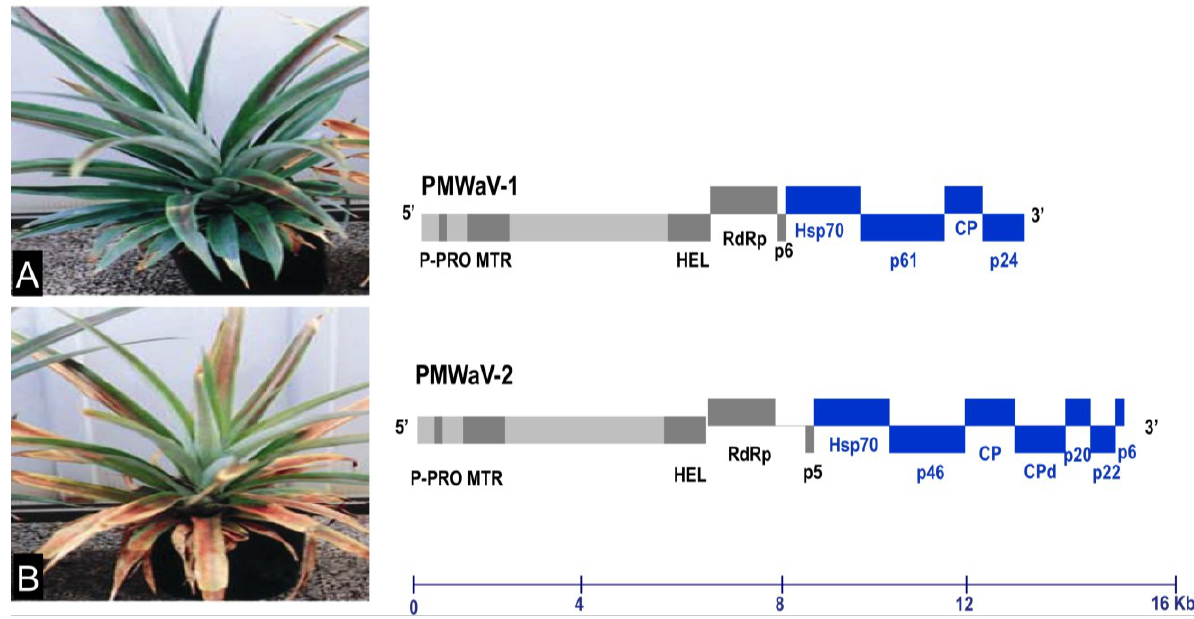
Figure 1. The genome organizations of PMWaV-1 and PMWaV-2. A symptomless pineapple plant infected by PMWaV-1 ( A ) and a symptomatic pineapple plant ( B ) infected by PMWaV-2 exhibiting typical wilting symptom are depicted alongside their genome organizations. Boxes represent open reading frames (ORFs), homologous genes, or domains are shown with the same pattern for both viruses. Blue boxes represent ORFs that were selected for screening of RNA silencing suppressor